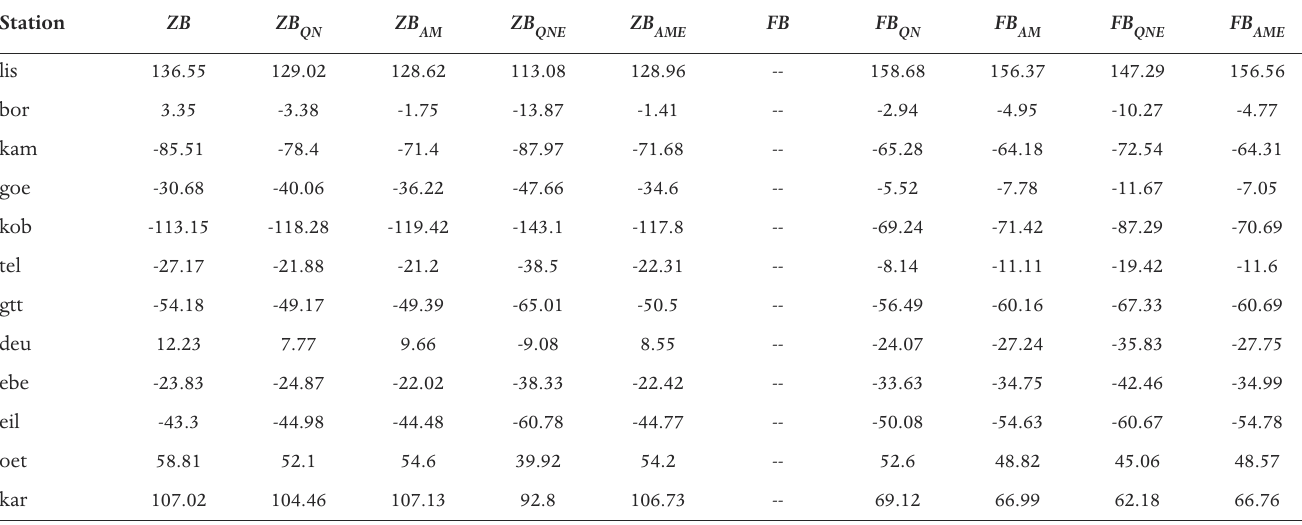
Table 4. Crustal bias estimates for Z and F component in nT.